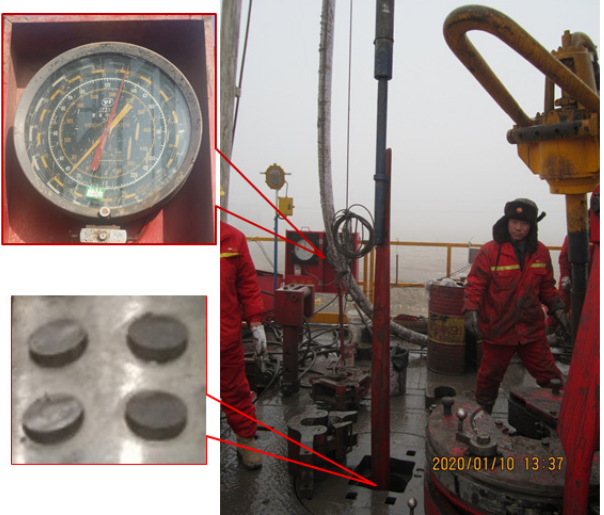
Figure 20. Setting experiment of inserted tooth slip sidetracking packer.